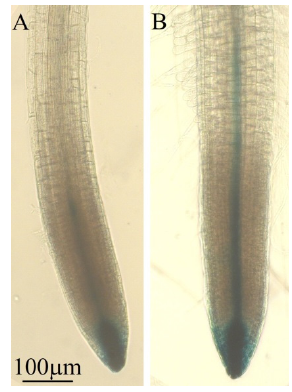
Figure 9. Effects of PS01 on auxin distribution in the Arabidopsis root. Images of DR5::GUS expression in mock treated root ( A ) and inoculated root ( B ) after 7 d of co-cultivation. Three replicates were performed with a total seedling population of 15; representative images are shown.